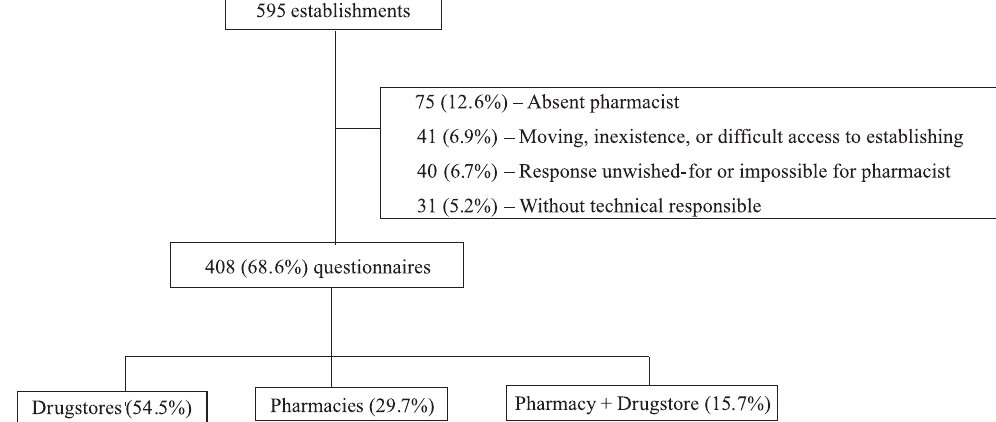
FIGURE 1 – Graphic schematization of adhesion index of establishments to